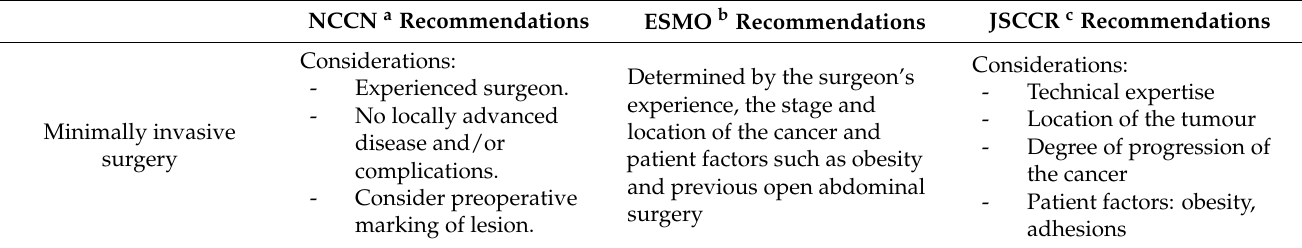
Table 9. Colorectal cancer: additional